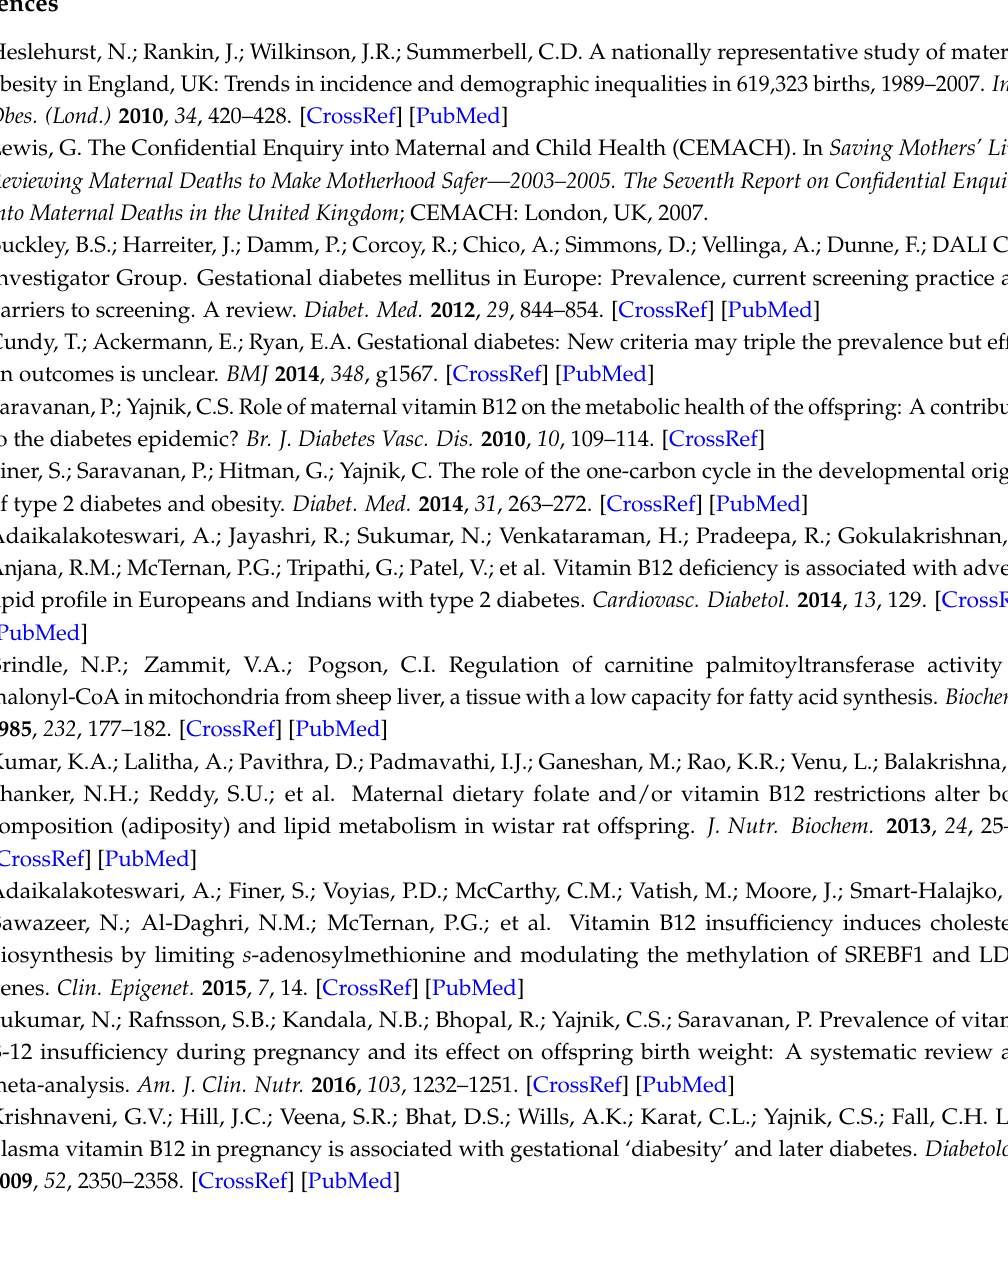
Table S1: Table of characteristics of no-GDM women who did and did not undergo GTT, Table S2: Table of birth outcomes of offspring according to maternal GDM